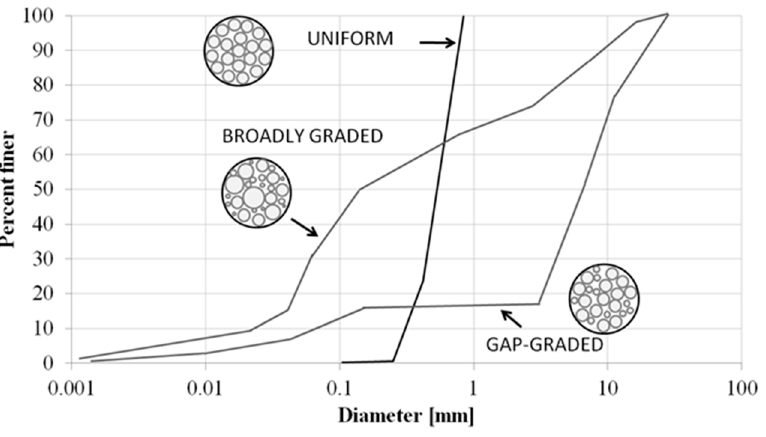
Figure 8. The typical grain size distributions of internally unstable (broadly graded and gap-graded soils) and stable soils (uniform soils).